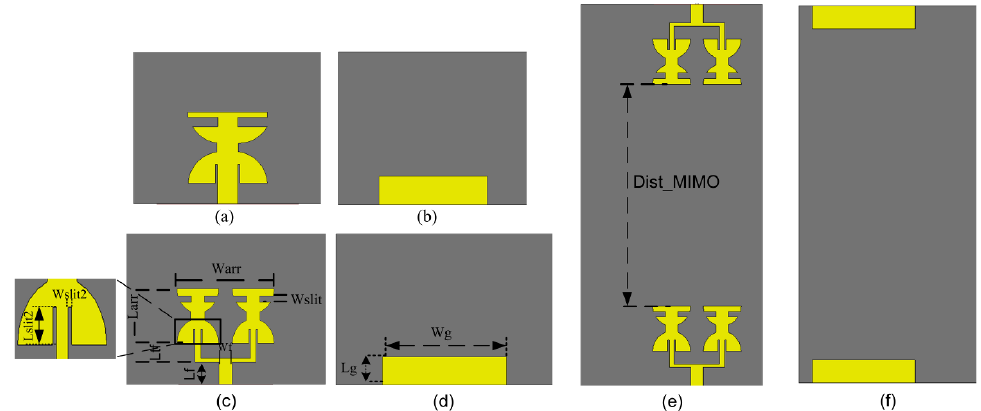
Figure 3. Mid-band MIMO final antenna design progression stages: ( a ) single element, front; ( b ) single element, back; ( c ) array, front; ( d ) array, back; ( e ) MIMO antenna configuration, front; ( f ) MIMO antenna configuration, back.